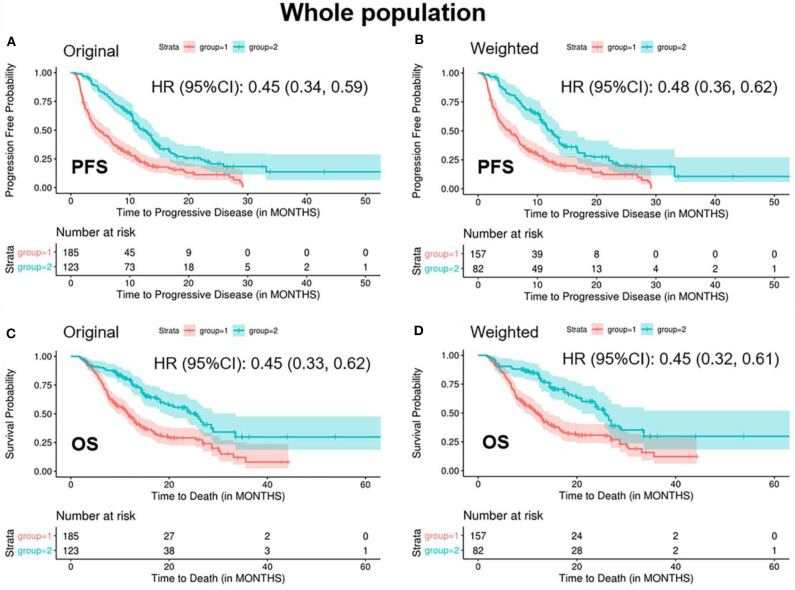
Kaplan-Meier curves of PFS/OS in the original and weighted sample of whole population. group 1: meaningful improvements in <2 out of 4 biomarkers (CEA, CA125, CYFRA21-1, and SCC-Ag); group 2: meaningful improvements in ≥2 out of 4 biomarkers (CEA, CA125, CYFRA21-1, and SCC-Ag). Kaplan-Meier curves of (A,C) were based on the original sample; Kaplan-Meier curves of (B,D) were based on the weighted sample.